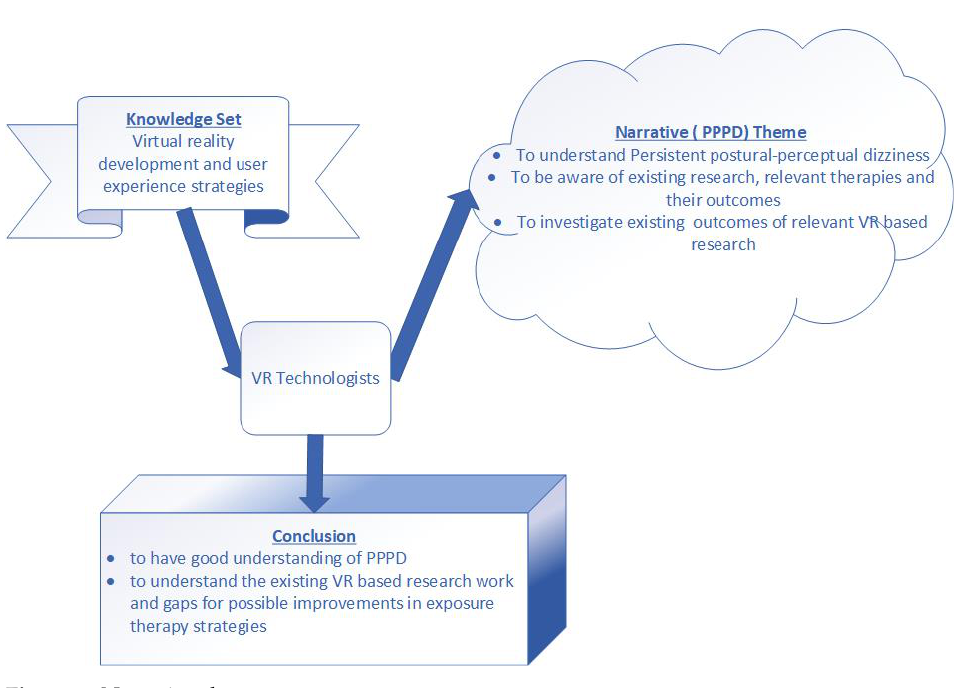
Figure 2. Narrative theme